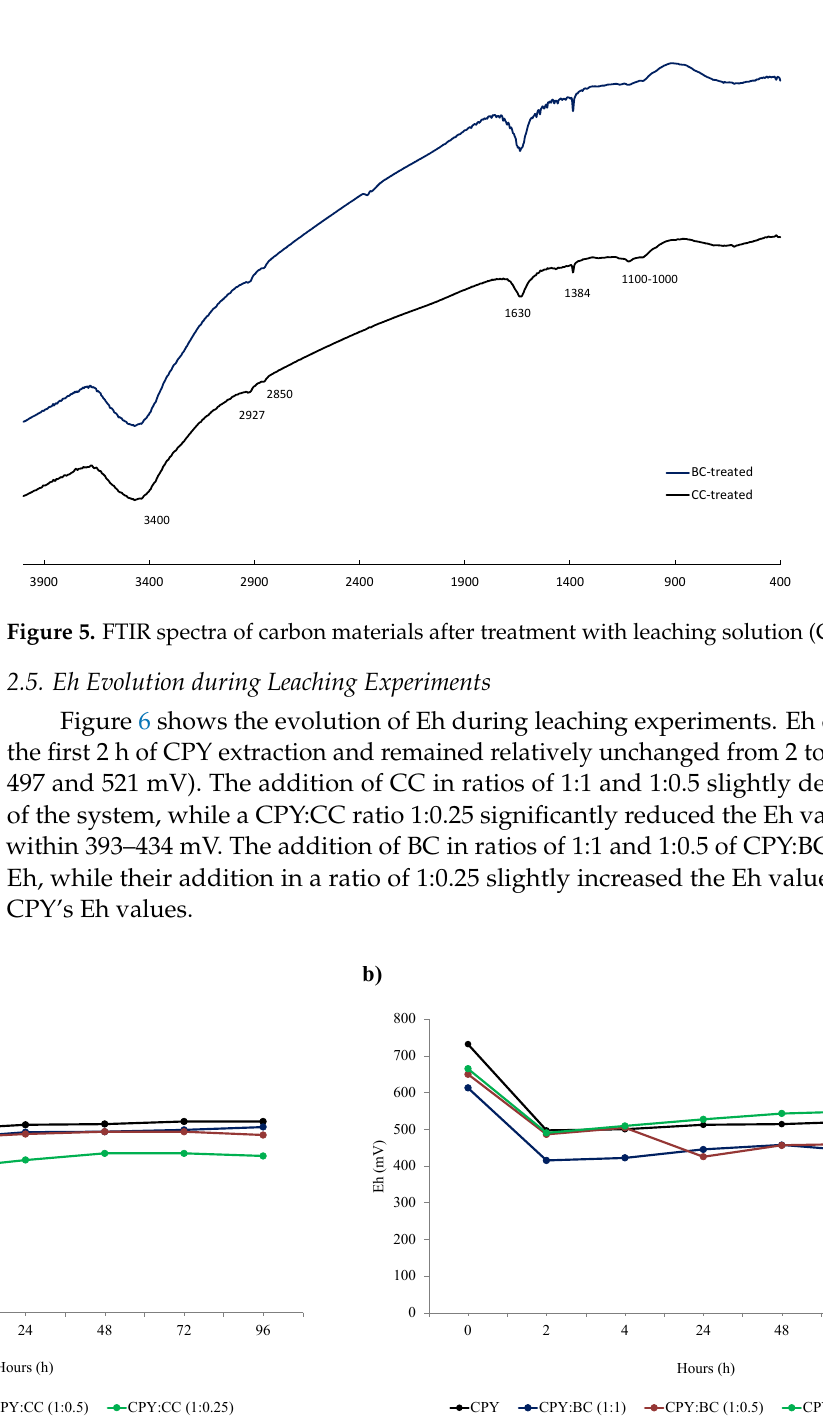
Figure 6. Eh (mV) evolution during leaching experiments with the addition of carbon materials: ( a ) CC and ( b ) BC .